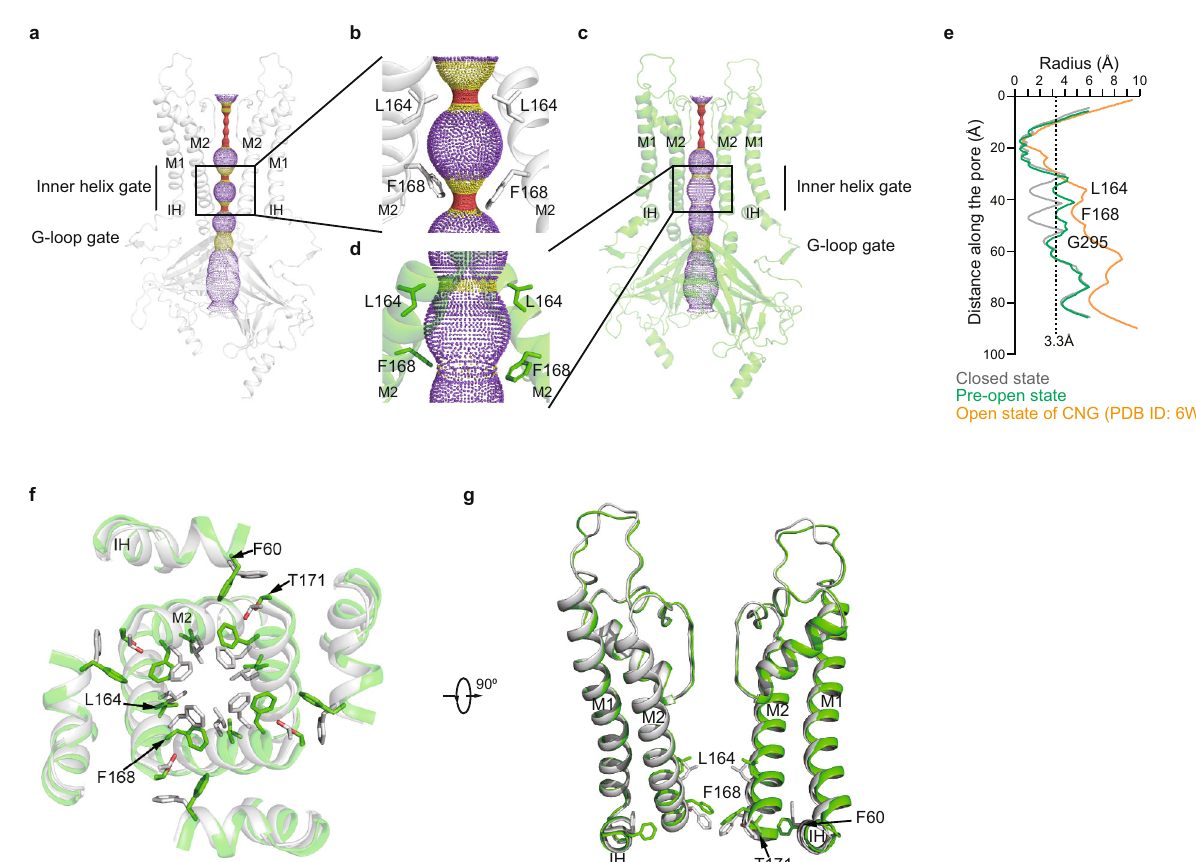
Fig. 2 The conformational changes of Kir6.2 TMD during K ATP channel opening. a Side view of Kir6.2 subunits of H175K cryo-EM in the closed state. The ion conduction pathway along the pore is shown as dots and colored as red, yellow, and purple according to the pore radii of <1.4, 1.4 – 3.3, and >3.3 Å. M1, M2, and IH are labeled. For clarity, the subunits in front and in the back were omitted. b Close-up view of M2 helices in ( a ) with gate residues shown as sticks (L164 and F168). c Side view of Kir6.2 subunits of H175K cryo-EM in the pre-open state. d Close-up view of M2 helices in ( c ). e Calculated pore pro fi les of the H175K cryo-EM closed state (gray), H175K cryo-EM pre-open state (green), and the open state of CNG channel (PDB ID: 6WEK) (orange). The size of a fully hydrated potassium ion (3.3 Å) is shown as dashes. f Structural comparison of the transmembrane domain between the closed state (gray) and the pre-open state (green). g A 90° rotated view of ( d ).